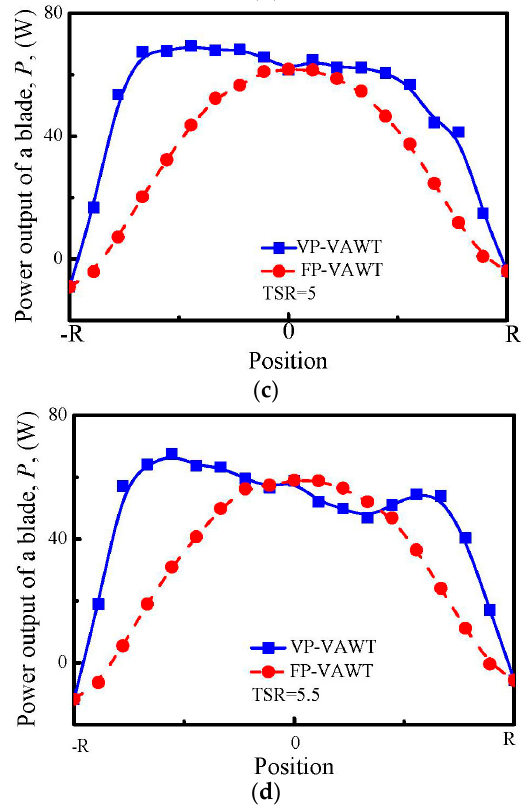
Figure 14. Power output of a blade as a function of position in VP-VAWTs and FP-VAWTs. ( a ) TSR = 4; ( b ) TSR = 4.5; ( c ) TSR = 5; ( d ) TSR = 5.5.